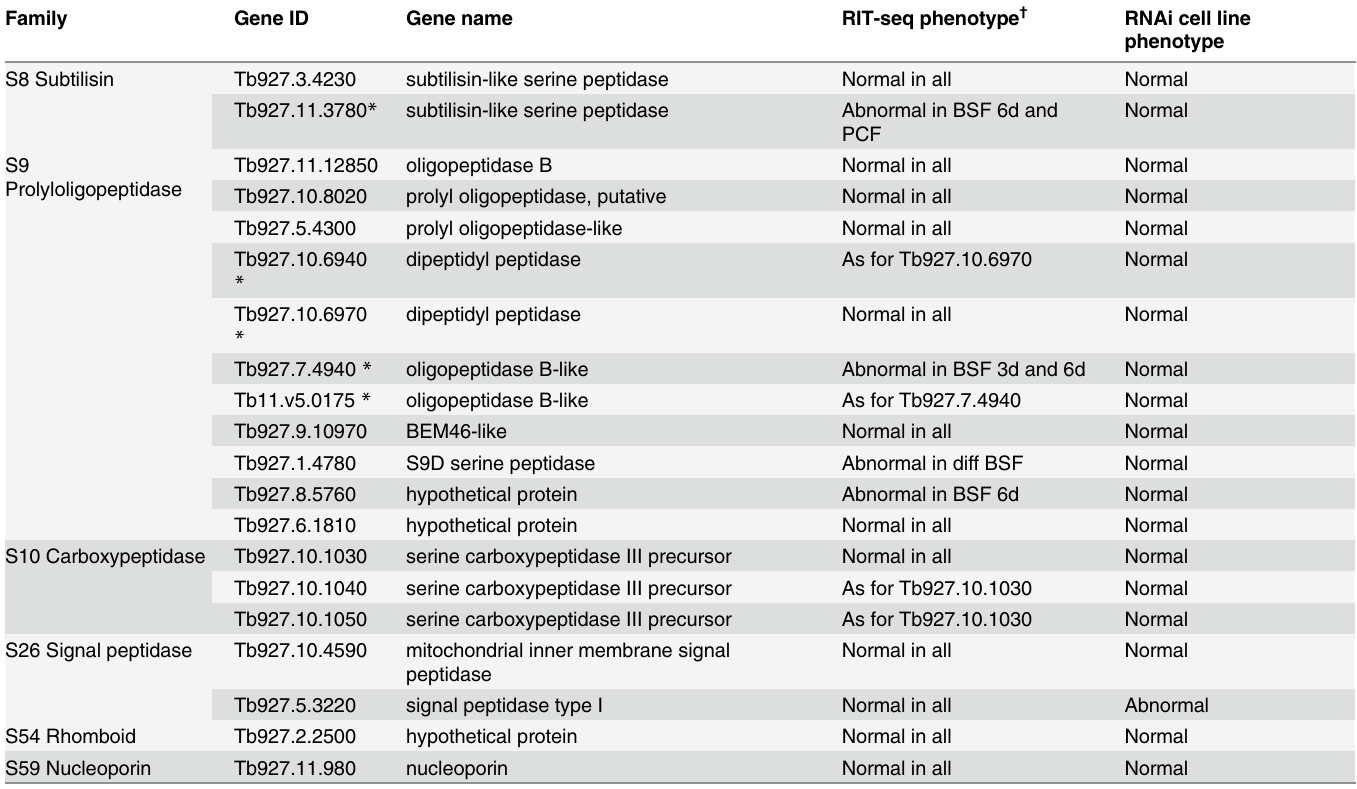
Table 1. Comparison of serine peptidase RNAi screen with RIT-seq